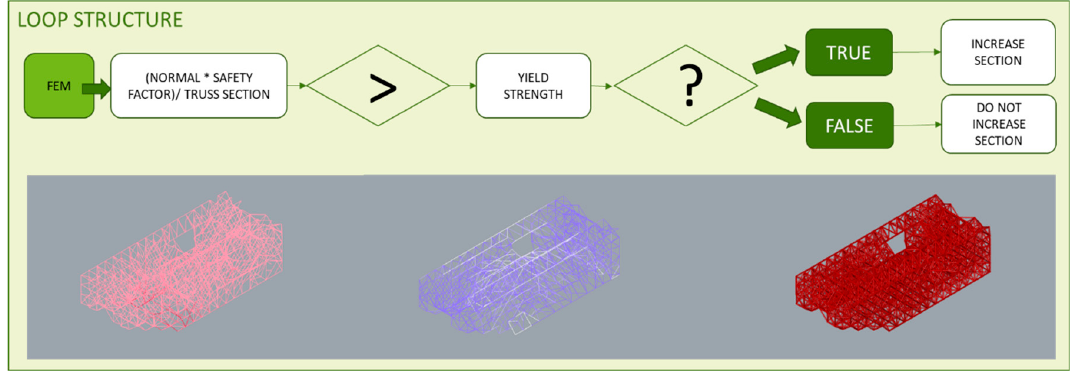
Figure 12. Loop sequence for the cross-section assignment.